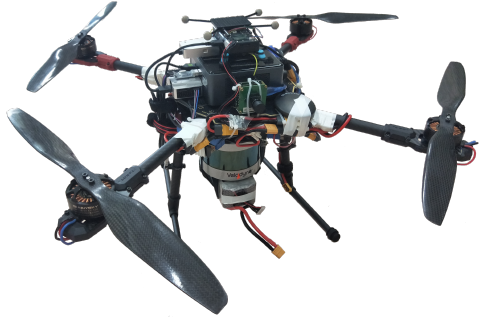
Figure 8. The quadcopter used for the indoor flight tests.